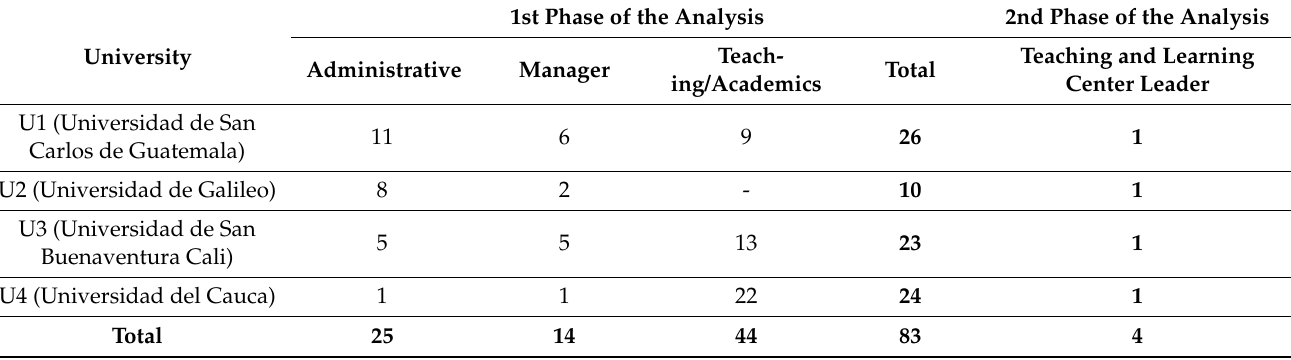
Table 1. Participants from the different universities in the different phases.